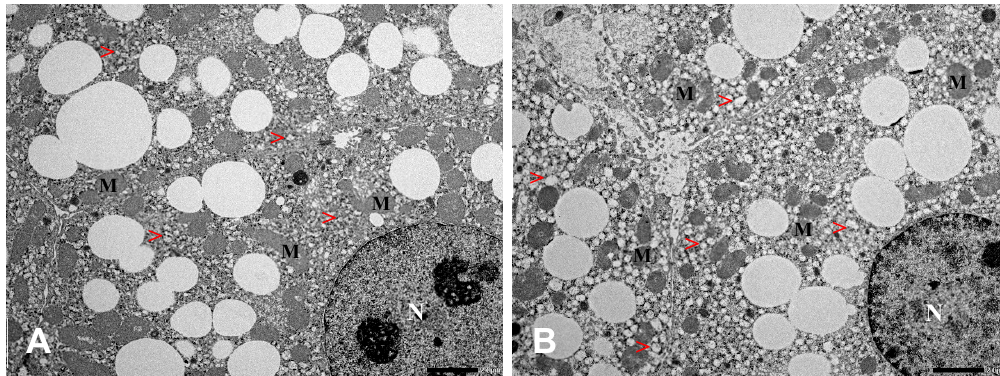
Figure 8. Liver tissue of wild type ( A ) and Tff3 knock-out ( B ) tunicamycin-treated mice analyzed by transmission electron microscopy (TEM); (M) mitochondria, (N) nucleus, (>) lipid droplets. The size of lipid droplets in hepatocytes appeared to be increased in Tff3 − / − mice compared to wild type mice. There was no difference in the ultrastructure of hepatocytes including cell bodies and cell organelles. Scale bar: 2 µm.